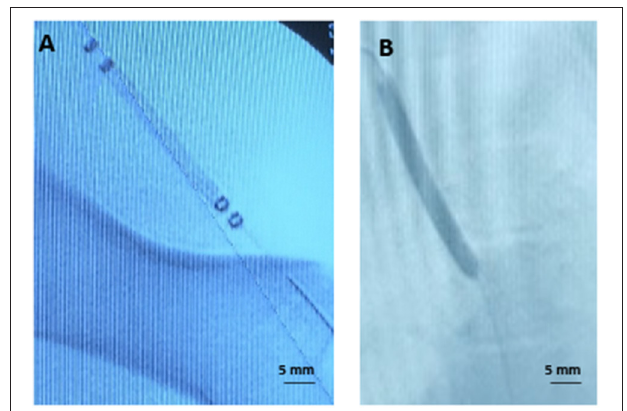
FIGURE 3 | Representative angiographic images. (A) Angiogram of the perfusion catheter during delivery. (B) Angiogram of the drug-coated balloon during delivery.